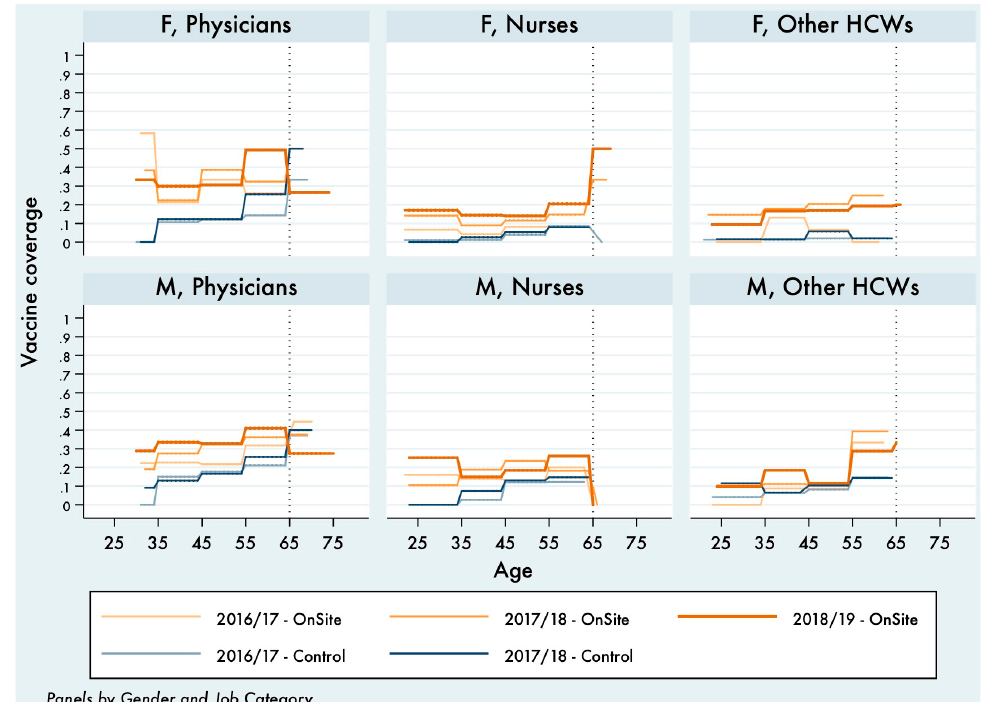
Figure 2. Vaccination coverage by age class, gender, OSV and job category during the three campaigns (model without interaction, available in Table 3).